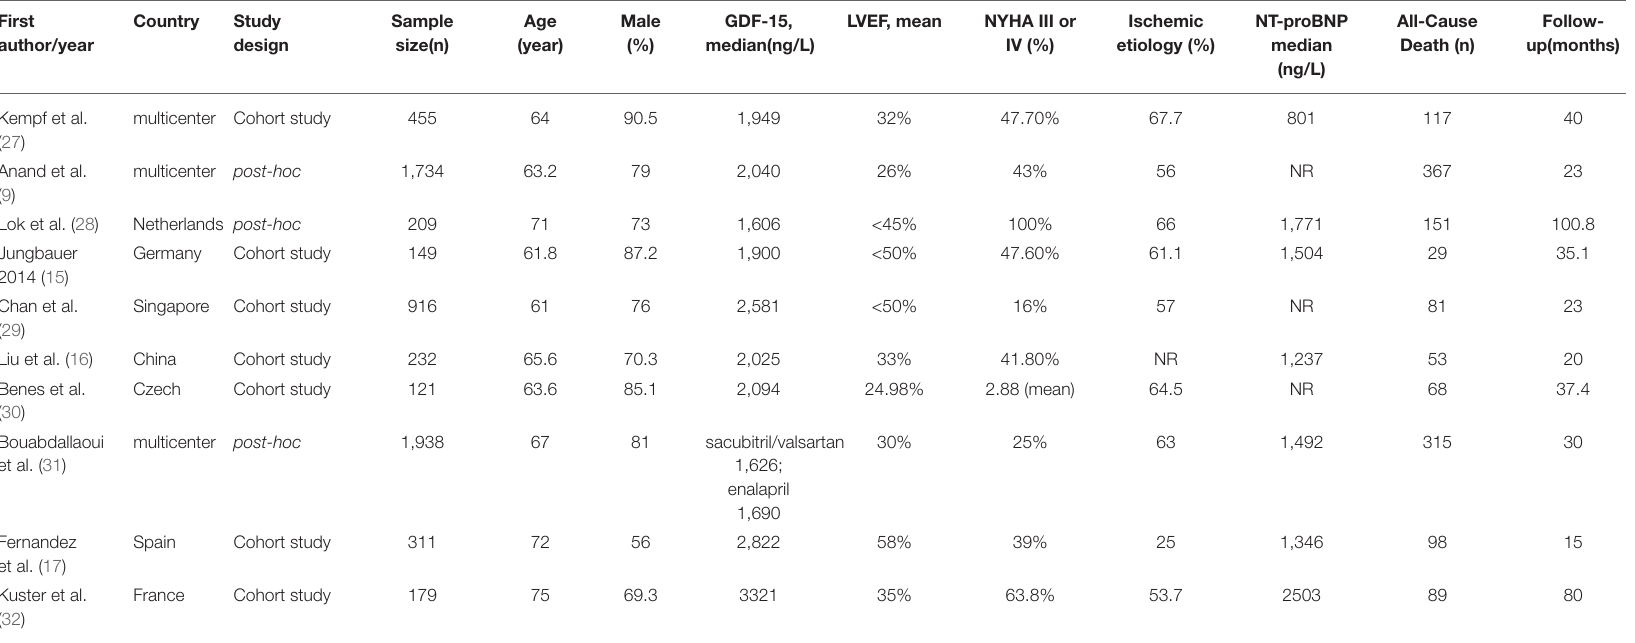
TABLE 1 | Baseline characteristics of the study